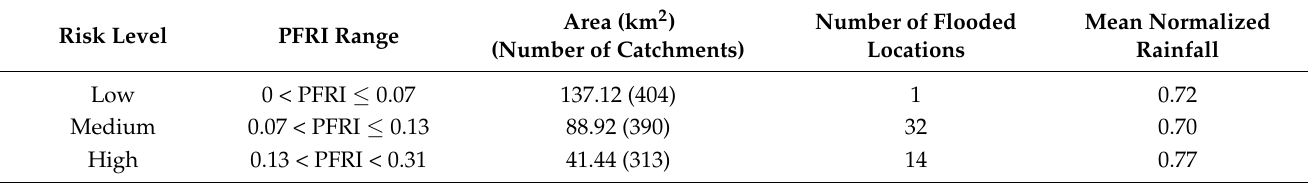
Table 4. Summary of PFRI values for the flooded locations based on PFRI